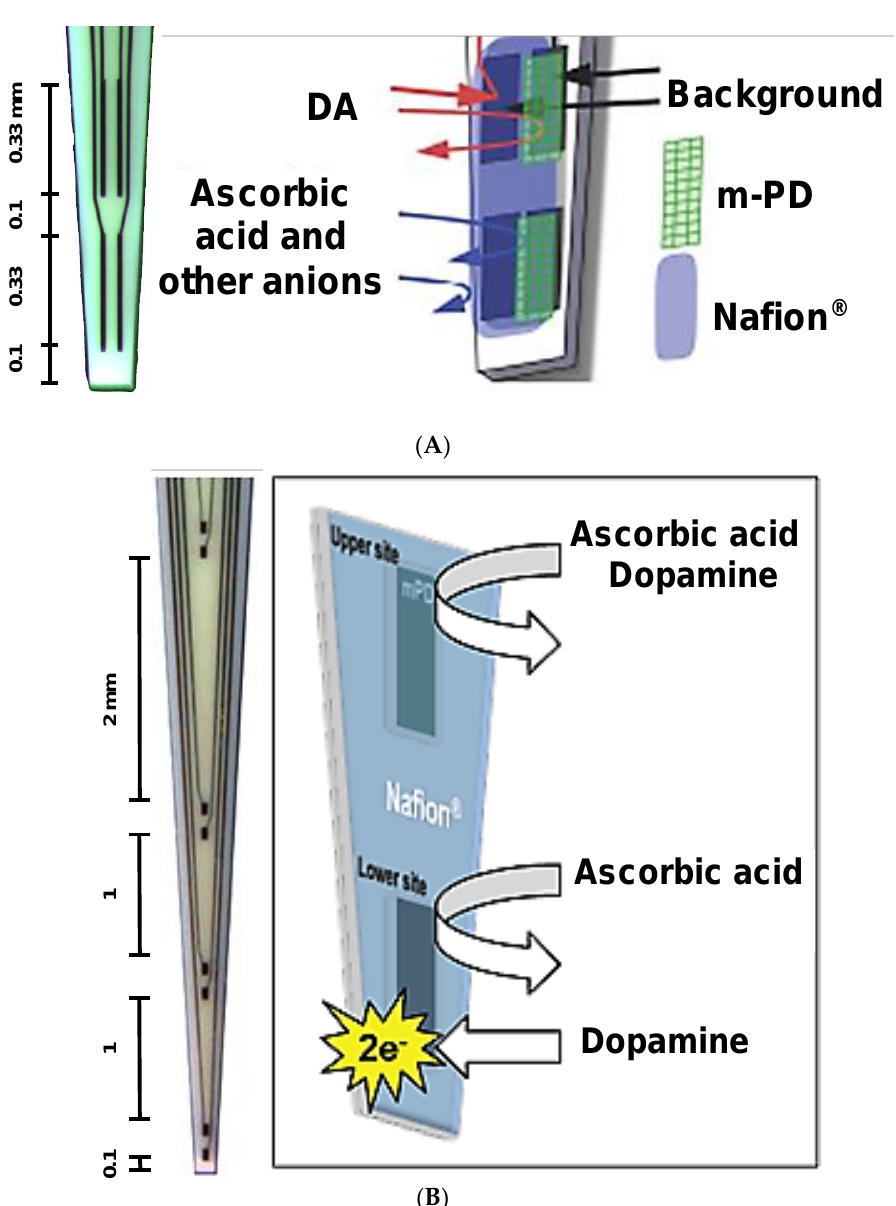
Figure 1. Microelectrode array (MEA) design and function as configured for dopamine (DA) measurement. Photomicrographs and corresponding schematics of Nafion ® -coating and selective electrodeposition of m -phenylenediamine (m-PD) for a ( A ) 4-channel S2 MEA (333 × 15 micron pairs) and ( B ) 8-channel DSPR8 MEA with reaction schemes are shown. The distance between recording pairs is also shown for both MEAs.